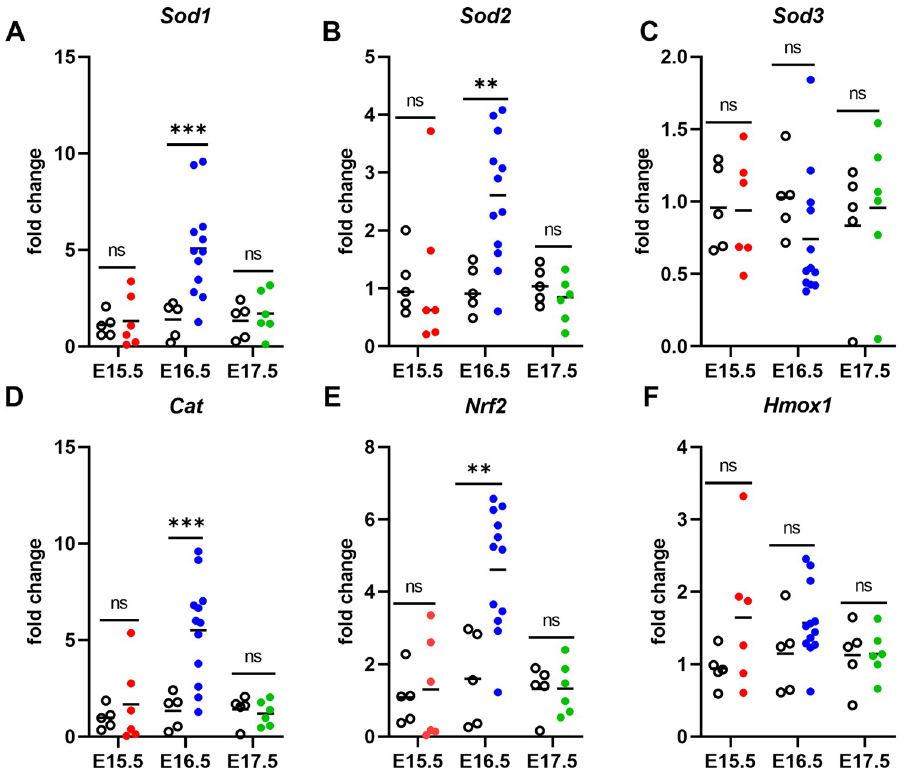
Fig 8. P . chabaudi infection at E8.5 induces elevated antioxidant gene transcript expression in the E16.5 placenta prior to preterm delivery. (A-F) Mouse Sod1 , Sod2 , Sod3 , Cat , Nrf2 , and Hmox1 mRNA abundance relative to Ubc and quantified by qPCR in placentae taken from infected pregnant (solid circles) and uninfected pregnant (open black circles) dams. Solid color circles denote pooled placentae from individual infected dams sacrificed on E15.5 (red), E16.5 (blue), and E17.5 (green). Open black circles are pooled placentae from uninfected pregnant controls for each group. Group means and transcript abundance in individual mice are depicted. ��� P � 0.005, �� P = 0.02; ns = not significant, P > 0.05.